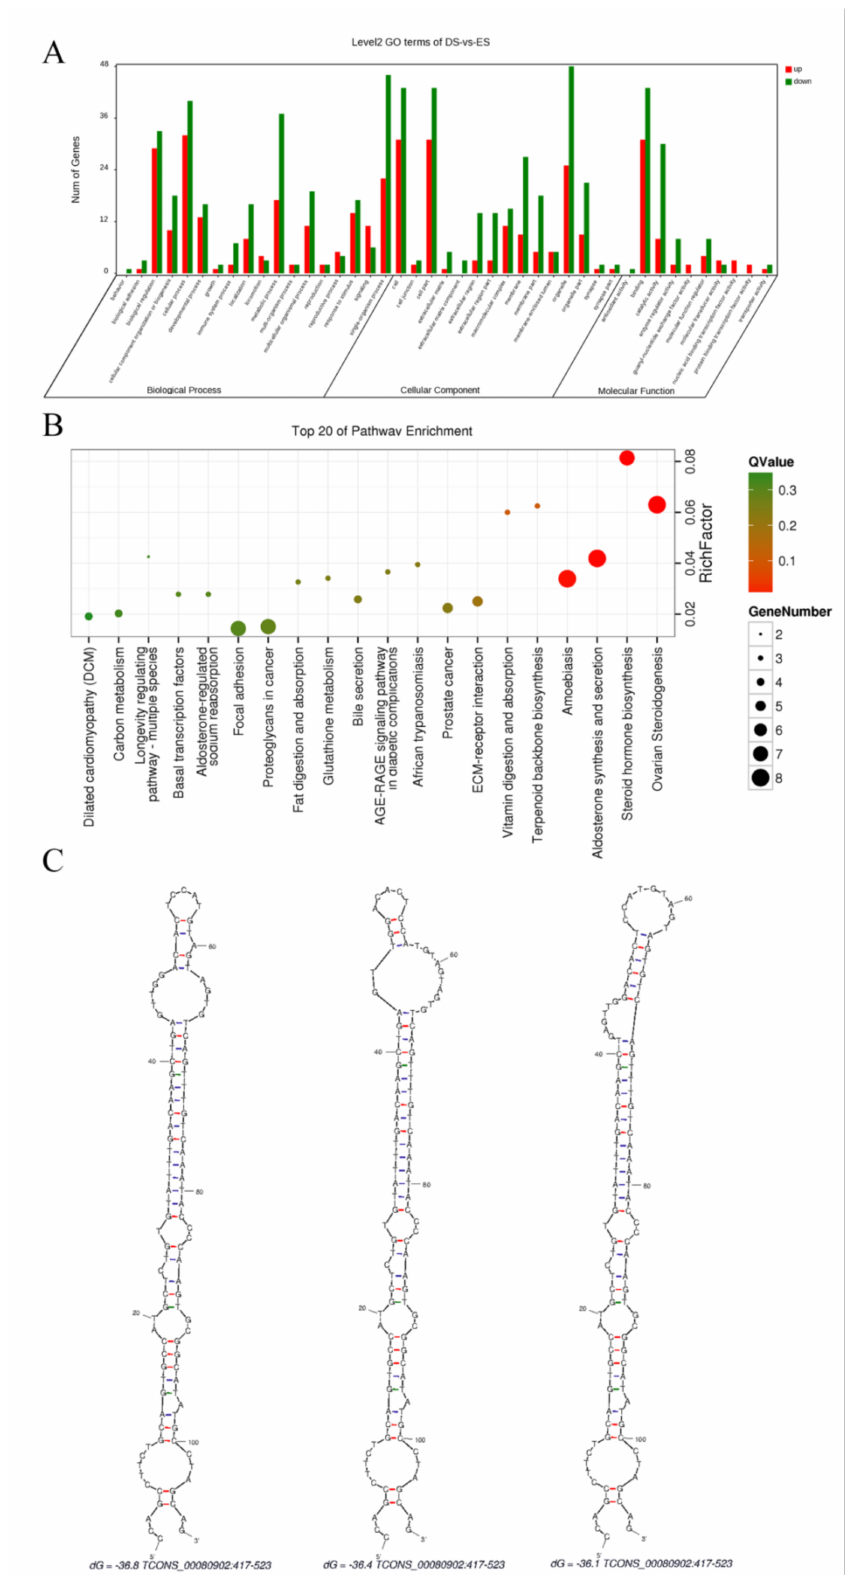
Figure 4. The analysis of mRNA and lncRNA. ( A ) The GO enrichment of differentially expressed mRNAs, ( B ) the KEGG pathway enrichment of differentially expressed mRNAs, and ( C ) the three predicted secondary structures of TCONS_00080902. The differentially expressed mRNAs were screened to explore the mRNA regulation in goat estrous cycle. GO enrichment ( A ) and